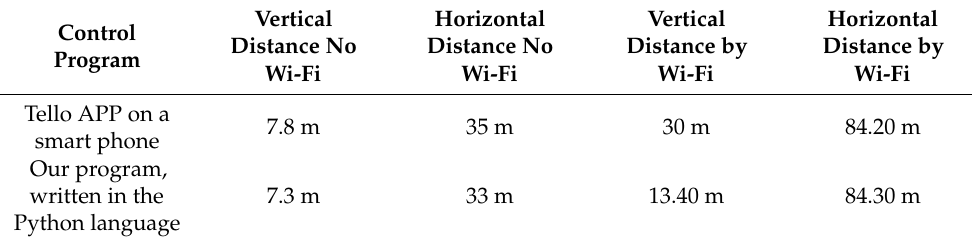
Table 2. Comparison of flight-control distances between Tello App and our design